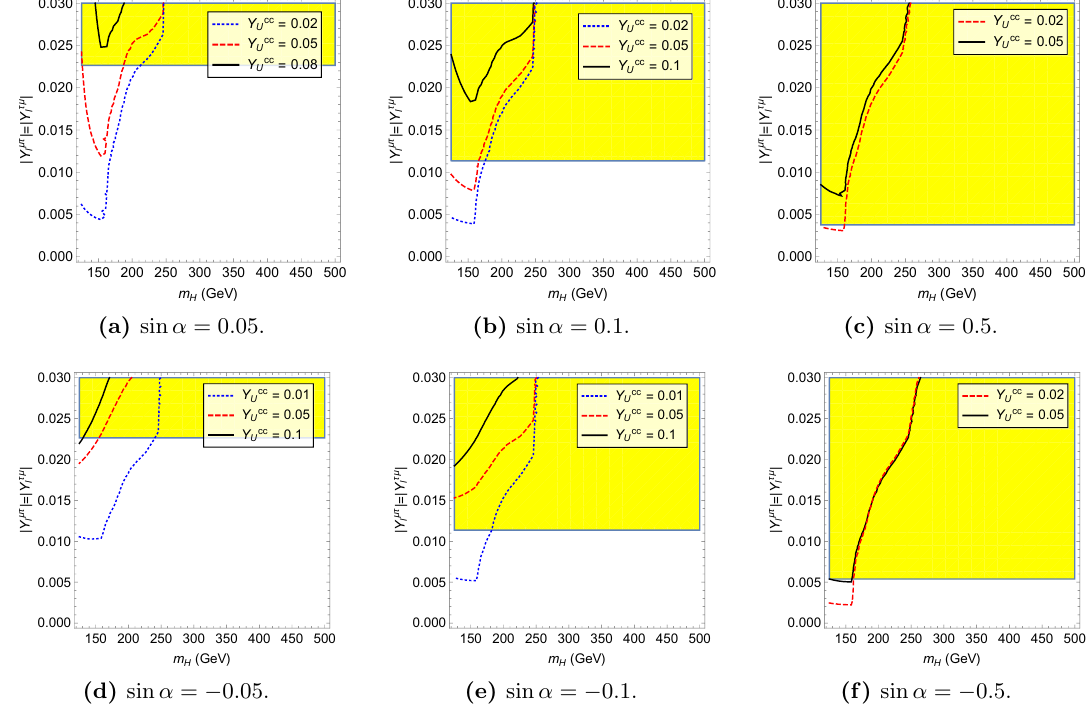
Figure 21. The estimated bounds for the heavy scalar LFV searches and their comparisons with the h LFV searches. The yellow region is excluded by the h LFV search. The region above the red, blue and black lines are excluded by the heavy scalar LFV search. Here we assume (cid:21) hhH = 1, m H < 2 m A and m H < 2 m H +